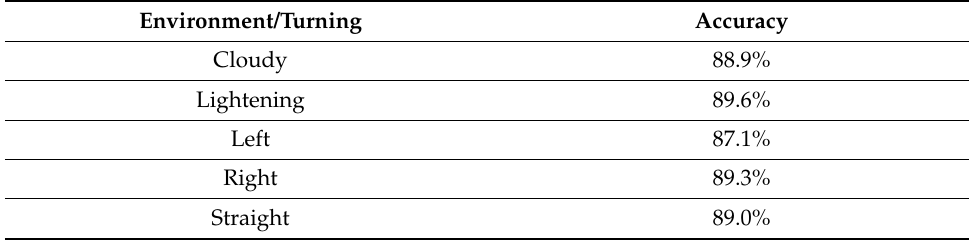
Table 2. Performance of the model on various environment/turn.